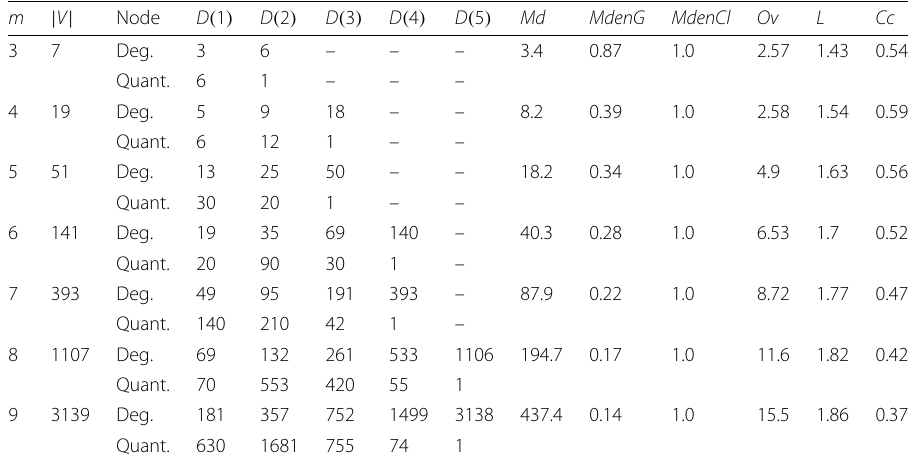
Table 1 The results of numerical calculation of the graph’s connectivity (parameters MDenV ( m ) and MDenCl are calculated for graphs without head nodes )